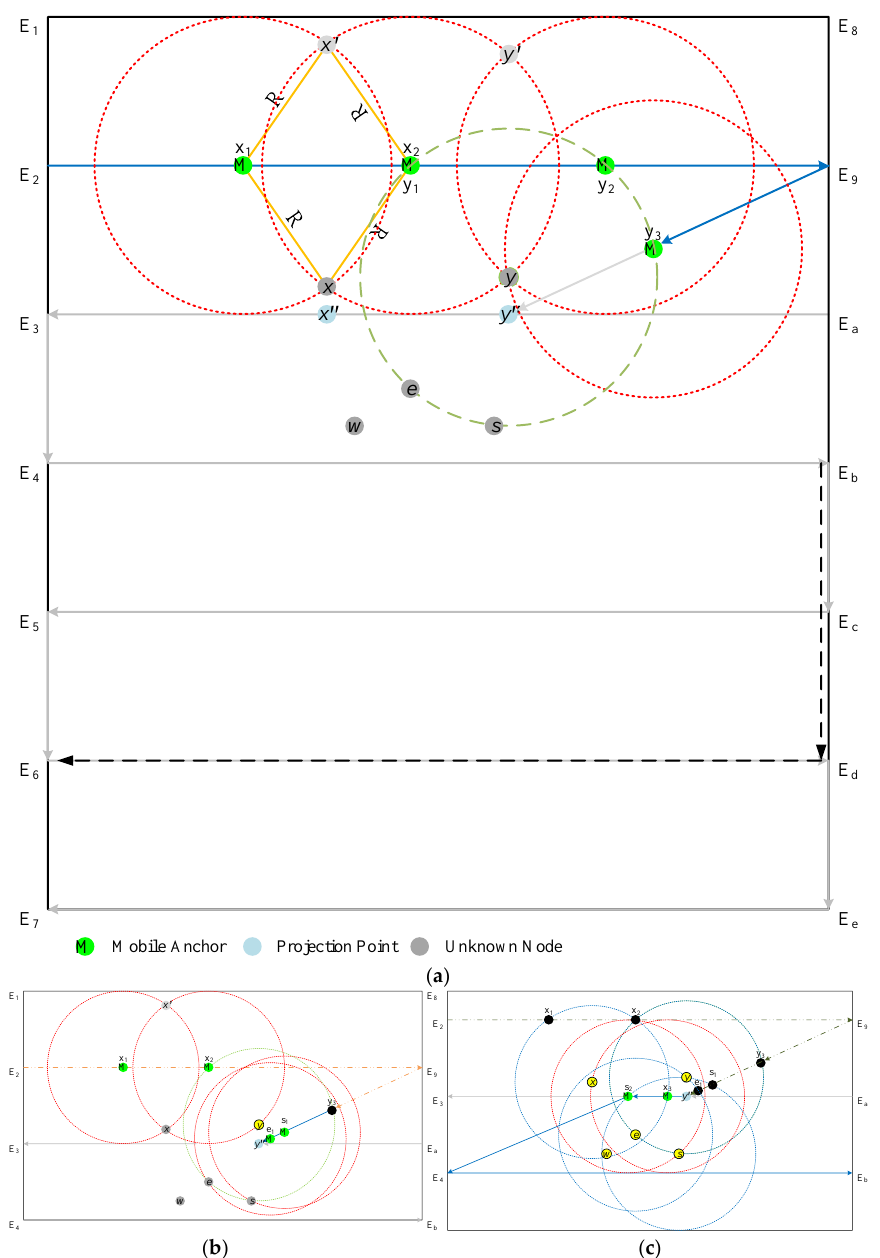
Figure 3. MARS with ISP algorithm: ( a ) the projection of MARS in the first line segment; ( b ) the unknown node has one position-aware neighbor; ( c ) the unknown node has two position-aware neighbors.